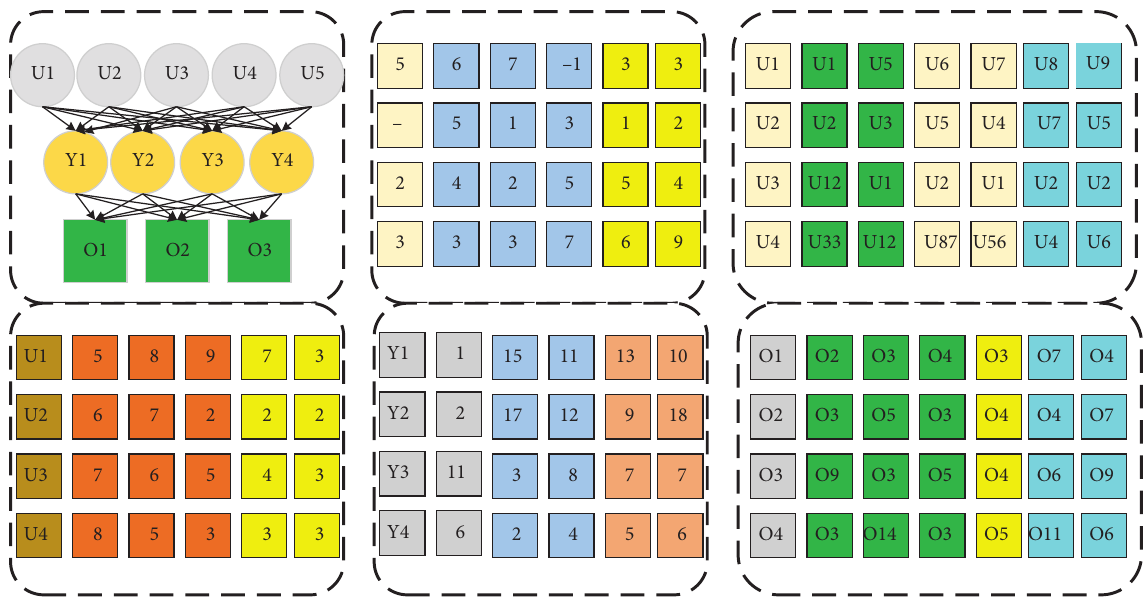
Figure 5: Experimental design of online user reputation ranking by cluster clustering.